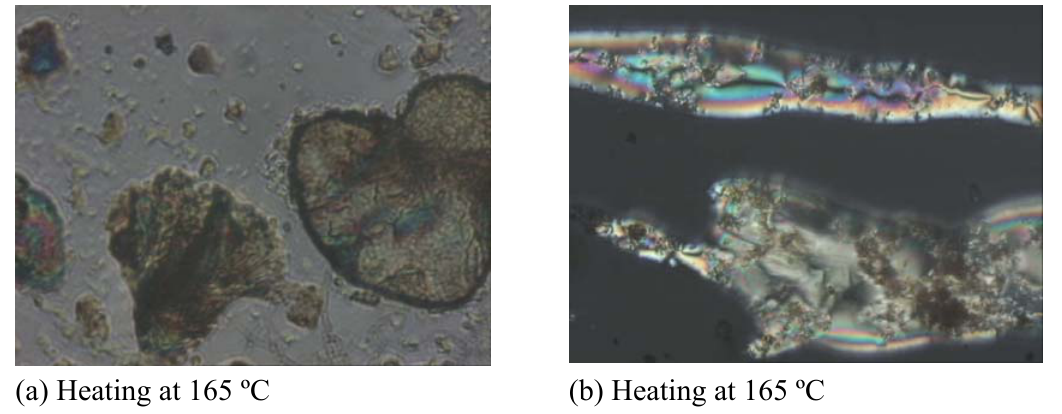
Figure 7. Polarizing Optical Microscope (POM) micrographs of (a) CdS: